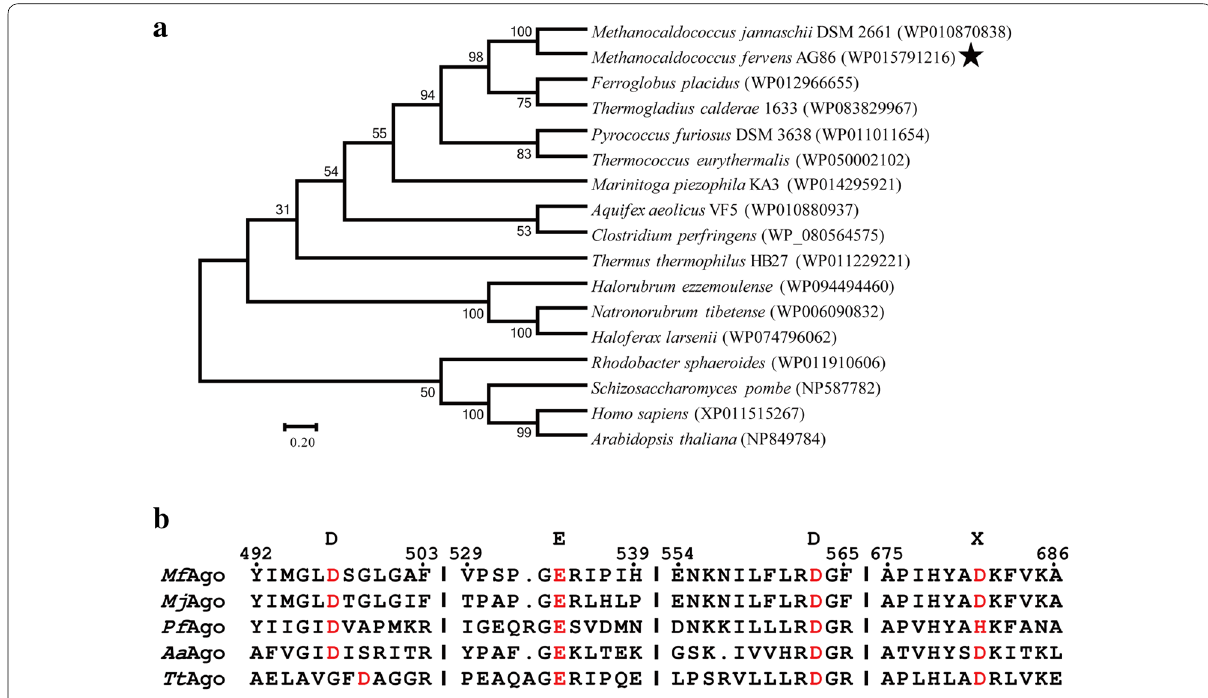
Fig. 1 Phylogenetic tree and sequence analysis. a Neighbor-joining phylogenetic tree analysis of Mf Ago based on amino acid sequences. The numbers at the nodes indicate the bootstrap values for neighbor-joining analysis of 1000 resampled data sets. The scale bar represents the evolutionary distance between species. Numbers in parentheses represent the sequence accession numbers in the NCBI database. b Multiple sequence alignments of Mf Ago with other known pAgos. Mj Ago: Ago from Methanocaldococcus jannaschii . Pf Ago: Ago from Pyrococcus furiosus . Aa Ago: Ago from Aquifex aeolicus . Tt Ago: Ago from Thermus thermophilus . Only regions containing the DEDX catalytic residues (indicated in red) are shown. The alignment was carried out using ClustalW, shaded manually and using ESPript 3.0 (Robert and Gouet 2014)